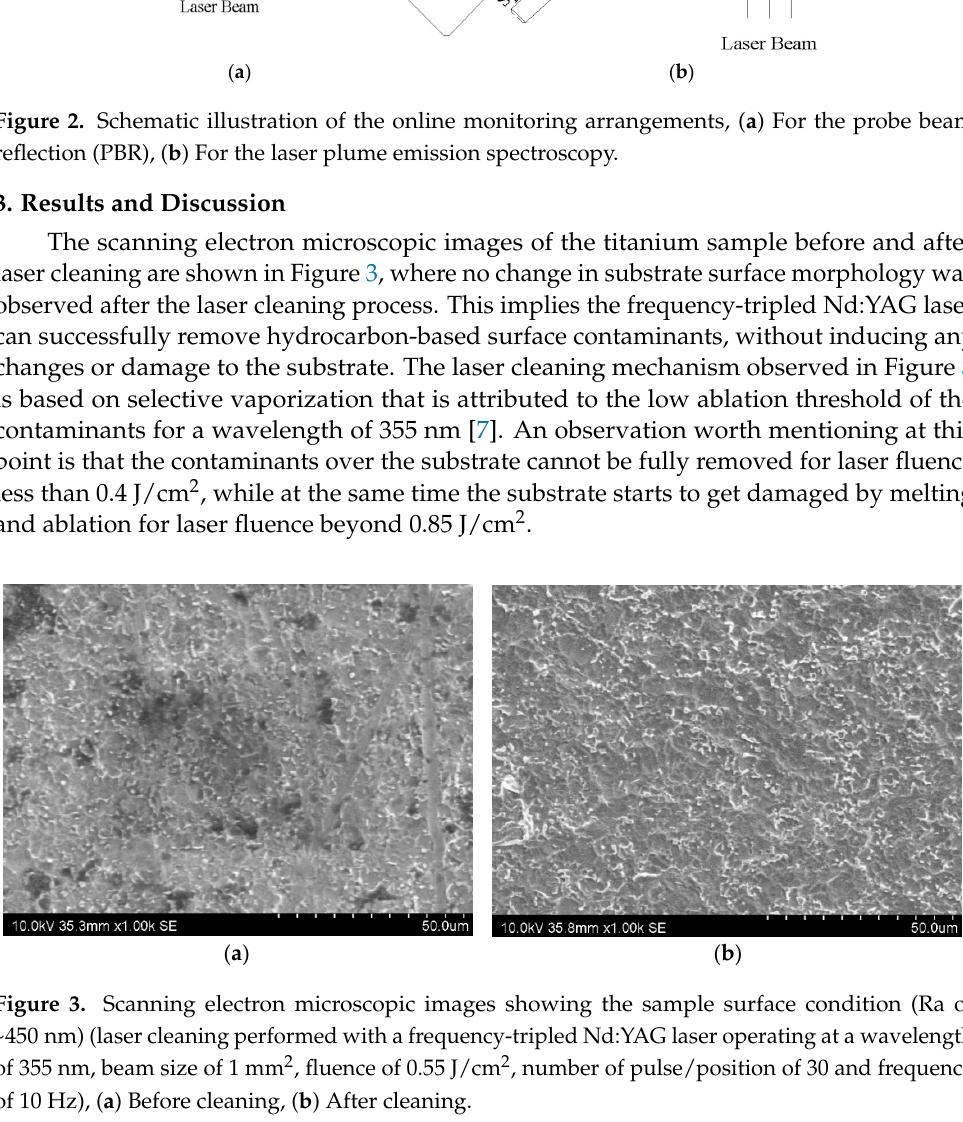
Figure 4. Reflectivity spectrum of a typical workpiece used for laser cleaning. At a wavelength of 635 nm, which corresponds to the wavelength of the diode laser to be used for monitoring, the figure shows the reflectivity of the laser-cleaned, uncleaned, and overcleaned samples to be 49%, 28%, and 44%, respectively. The least value of re- flected intensity observed for the overcleaned sample is possibly due to surface oxidation [12] of titanium alloy samples processed with a large number of pulses. Since there was a discerning difference in reflectivity of cleaned, uncleaned, and overcleaned samples, the monitoring process was expected to be feasible using a 635 nm diode laser for the PBR method.